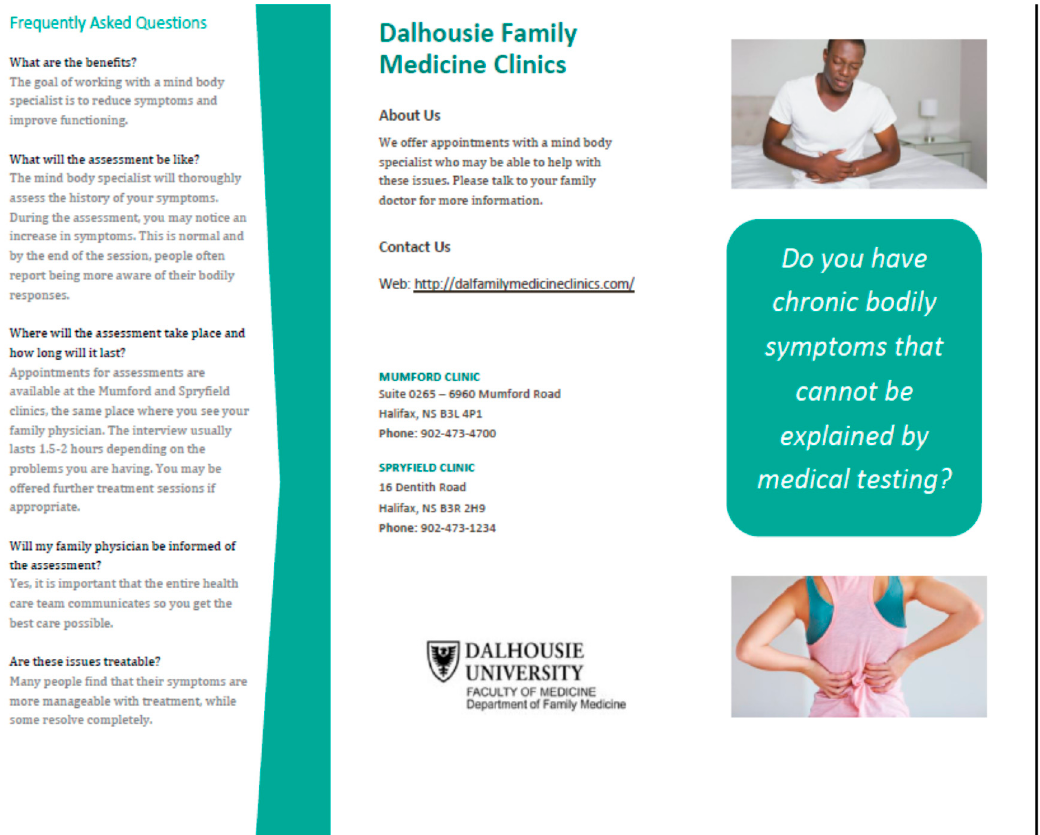
Figure A2. Patient Information Sheet (1).